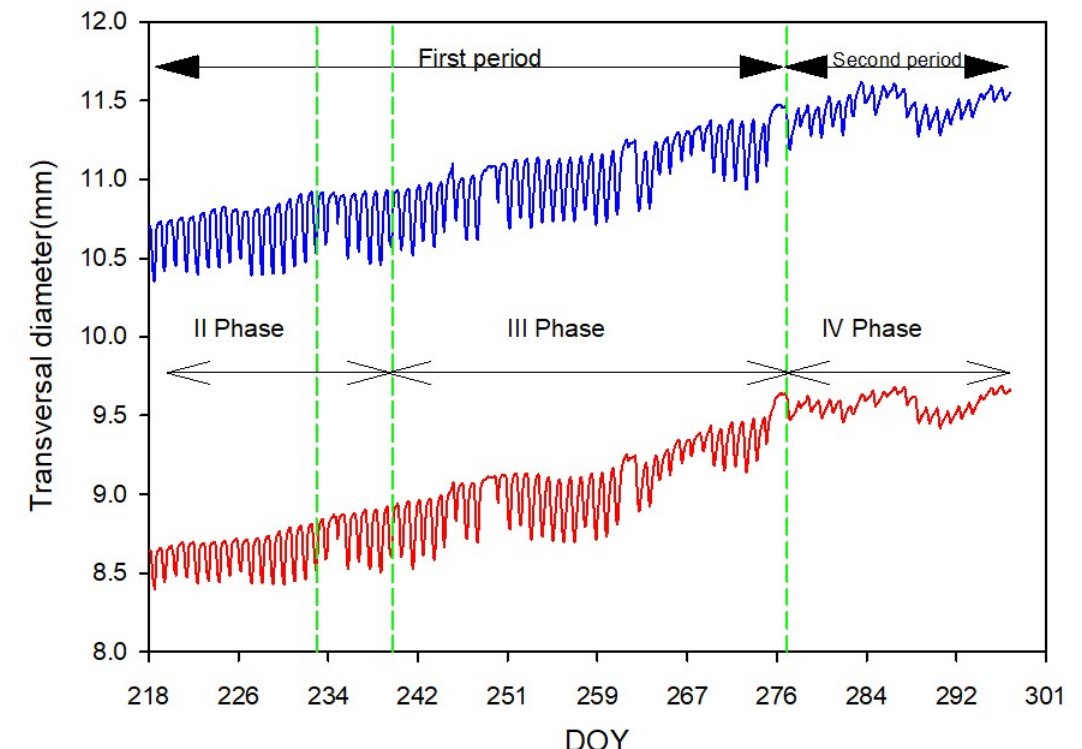
Figure 2. Continuous measurements of transversal diameter of fruit A (blue) and B (red). The first period of the study was from DOY 218 to 276 in 2019 and the second period of the study was from DOY 277 to 298 in 2019. Green dashed lines were drawn to separate fruit growth phases. An interval period of one week separated the end of the II phase from the following one. For this reason, there are two green dashed lines for ending the II phase of fruit growth.